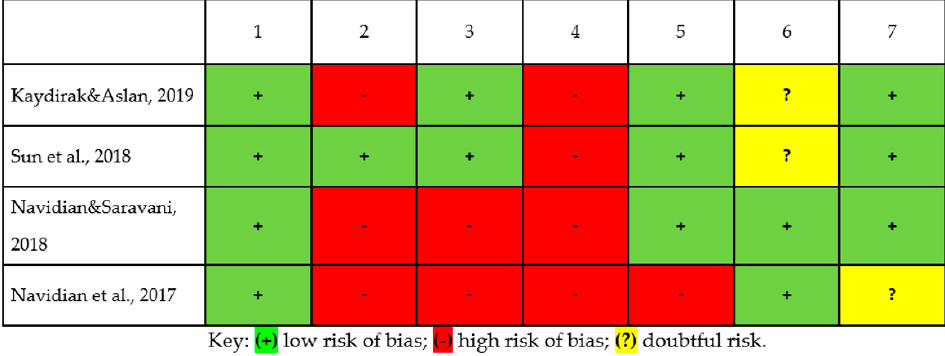
Figure 2. Risk of bias summary. Criterion number: 1, Random sequence generation (selection bias); 2: Allocation concealment (selection bias); 3: Blinding of participants and personnel (performance bias): 4: Blinding of outcome assessment (detection bias); 5: Incomplete outcome data (attrition bias); 6: Selective reporting of results (reporting bias); 7: Other bias (conflict of interests).